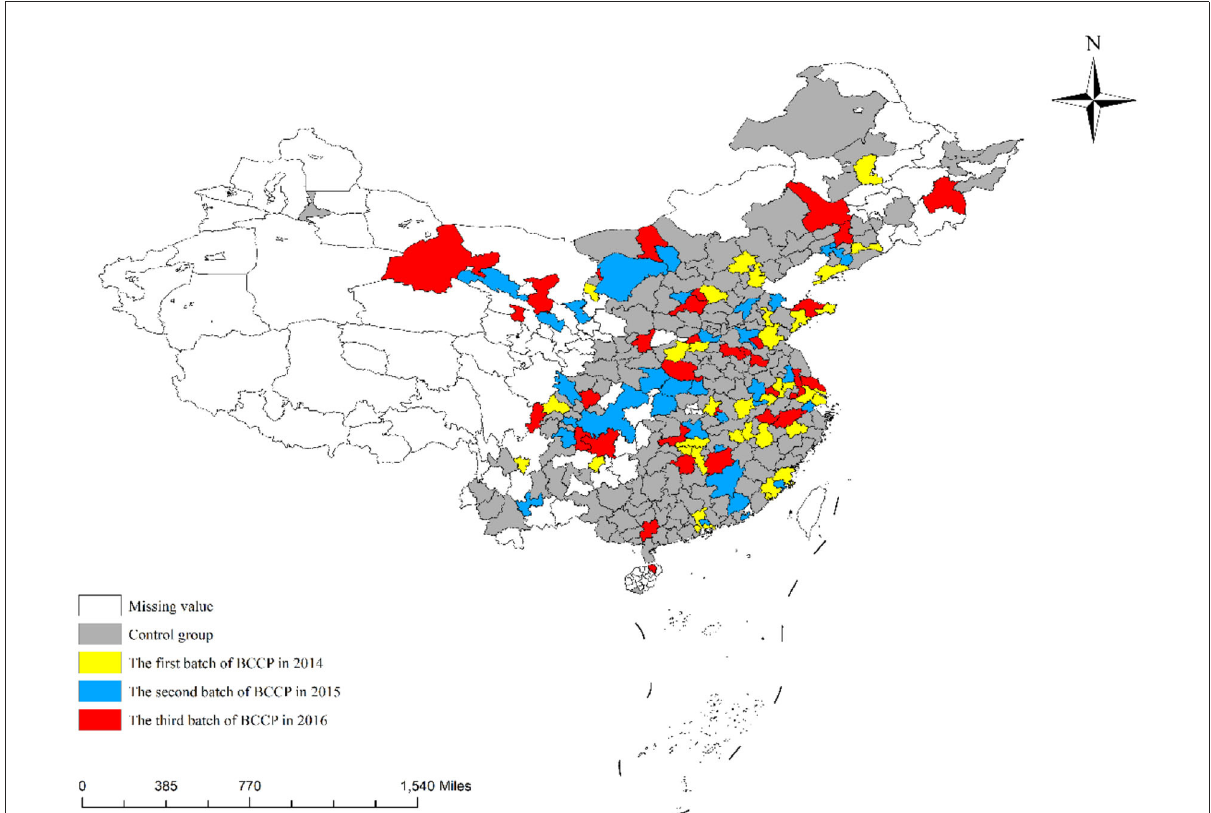
FIGURE1 Spatial distribution of the implementation of